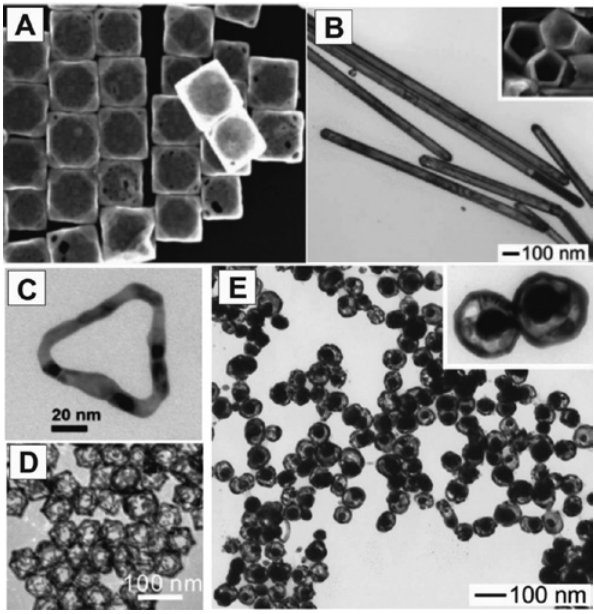
Figure 3: Electron microscopy images of various hollow nanostruc- tures. (A) SEM image of AuAg nanoboxes. (B) TEM image of